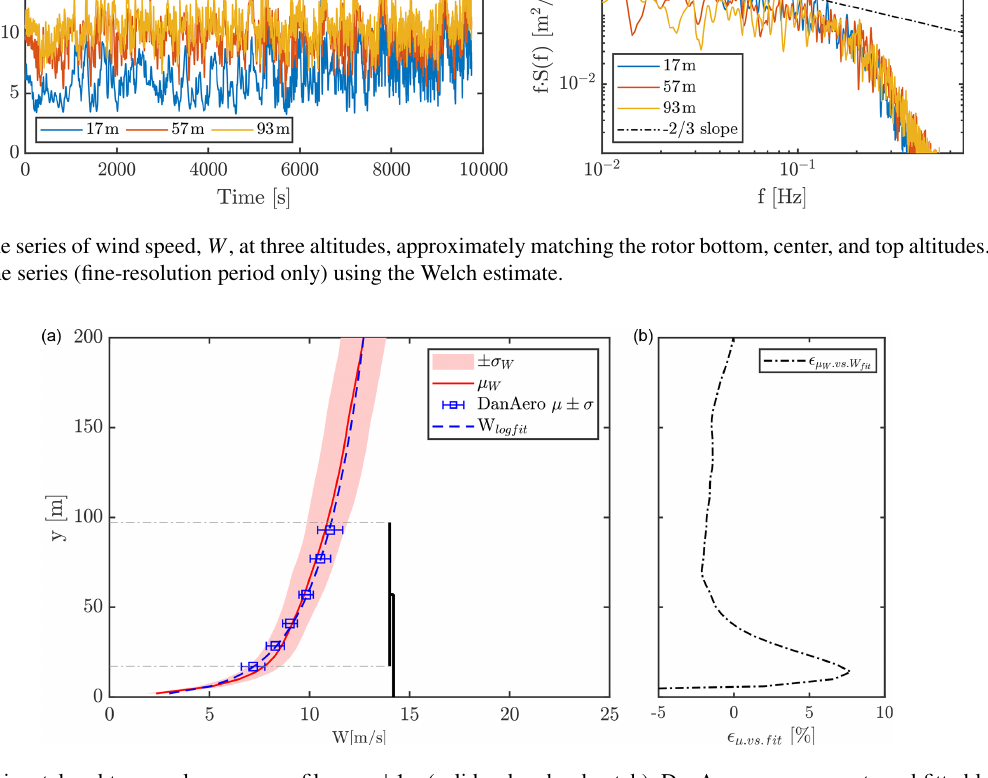
Figure 7. (a) Horizontal and temporal average profile µ W ± 1 σ (solid red and red patch), DanAero measurements and fitted log law (blue error bars and dashed). Horizontal averaging based on flow from ± 1 D from the rotor center on the sampled flow plane. (b) Relative error between log-law fit and µ W profile.